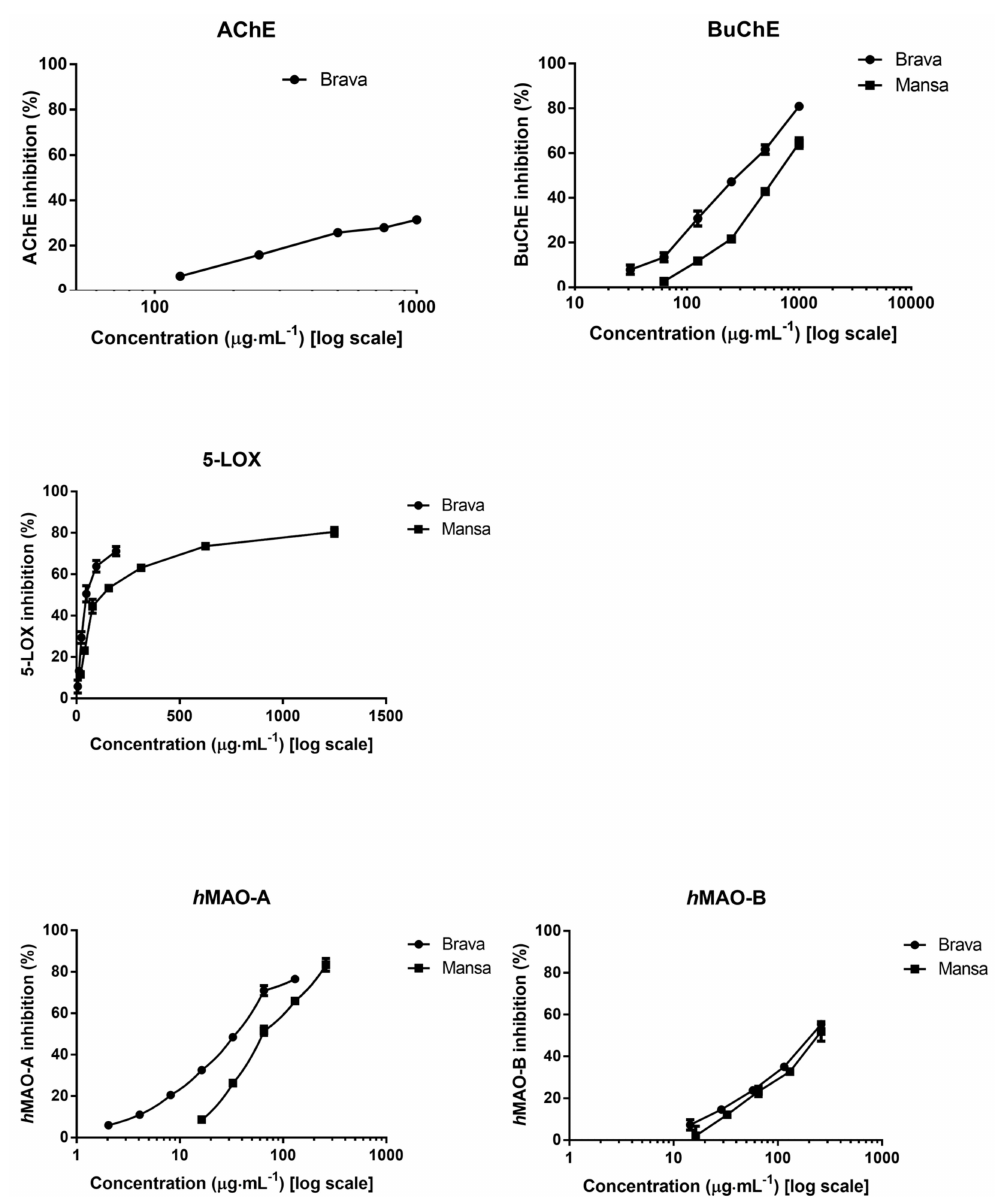
Figure 2. Inhibition of butyrylcholinesterase (BuChE), acetylcholinesterase (AChE), 5-lipoxygenase (5-LOX), monoamine oxidase A ( h MAO-A) and monoamine oxidase B ( h MAO-B) by phenol-rich extracts from (cid:48) Brava (cid:48) and (cid:48) Mansa (cid:48) EVOOs. Results are expressed as mean ± SD ( µ g · mL − 1 of dry extract) of three experiments, each performed in